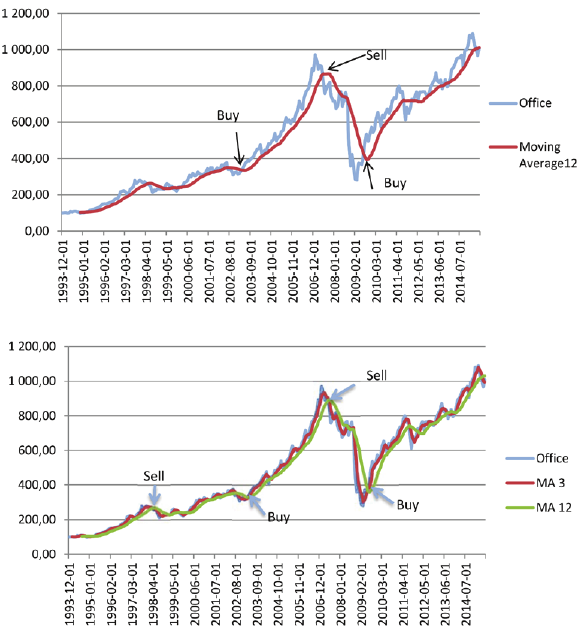
Figure 2. Illustration of the technical trading rule of 12 months moving average with the buy and sell signals